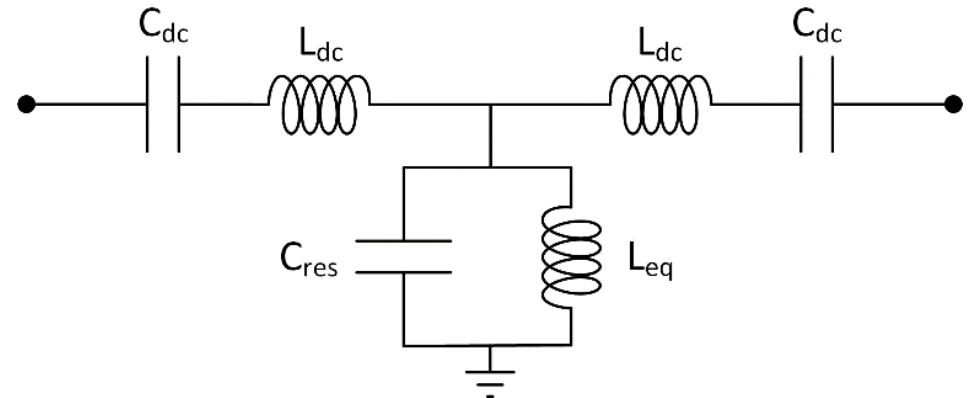
Figure 1. Topology of a single cell for bandpass active filters.